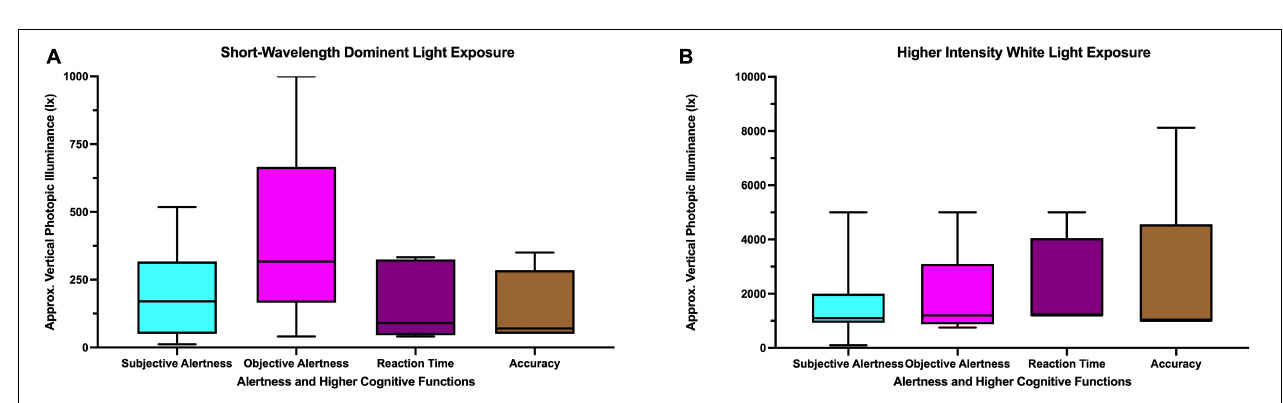
FIGURE 6 | Approximate vertical photopic illuminance for studies with (A) short-wavelength dominant light (B) higher intensity white light reporting beneficial influences on alertness and higher cognitive